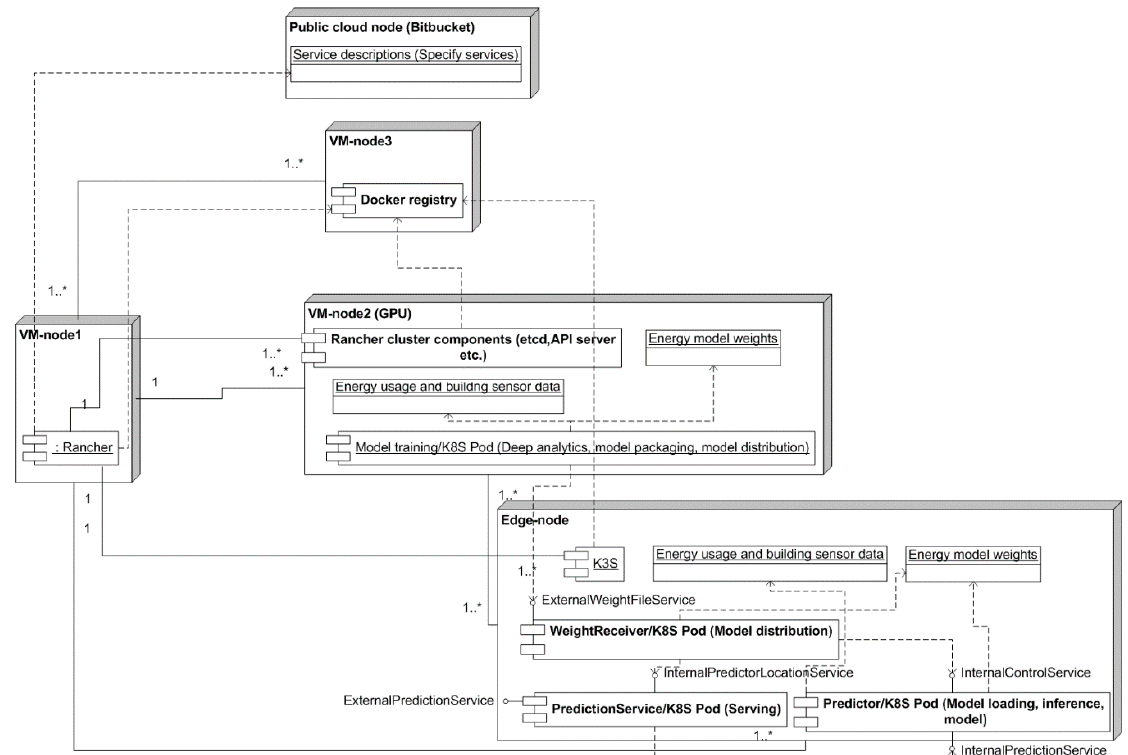
Figure 5. Unified Modelling Language (UML) deployment view of the